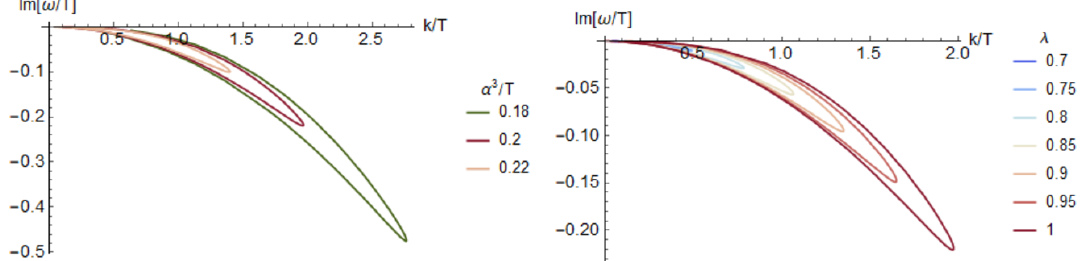
Figure 8 . The pole collision at (cid:22)=T = 3. Left: zoom on the dispersion relations before the mode collision for di(cid:11)erent values of the elasticity (cid:11) 3 =T . Right: zoom on the dispersion relations before the mode collision for di(cid:11)erent values of the EM coupling (cid:21) , at (cid:11)=T = 0 : 2.